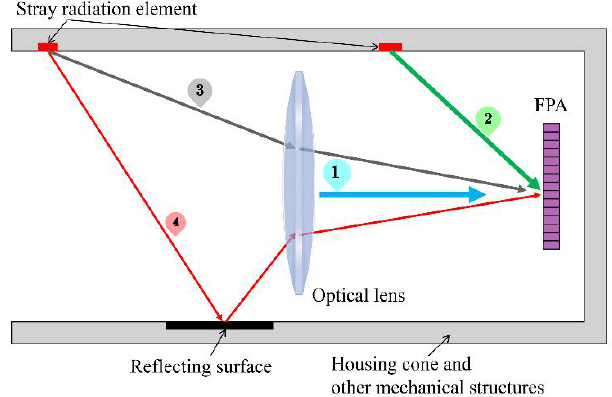
radiation from the